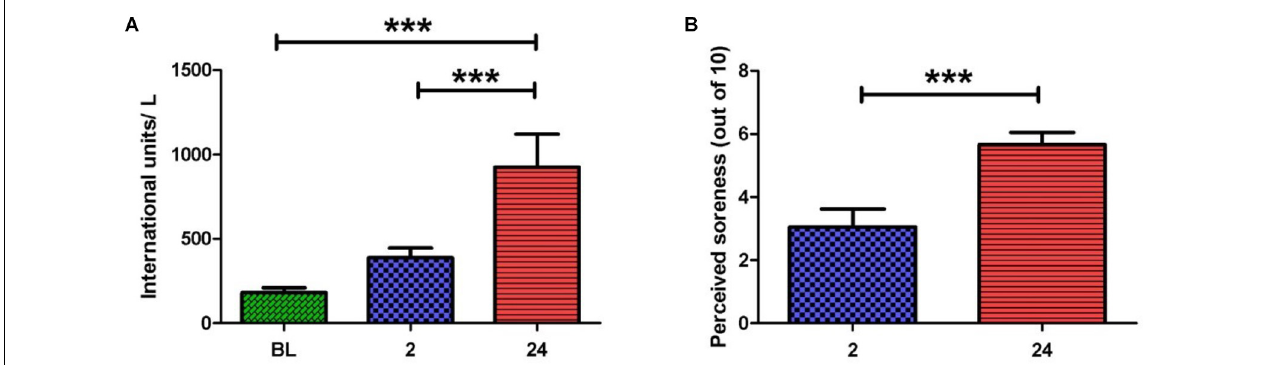
FIGURE 1 | (A) Serum creatine kinase activity before and after the exercise intervention. Values are represented in international units (IU) per liter. A large increase in scores is seen at 2 and 24 h post-exercise. (B) Perceived muscle pain of the anterior quadriceps upon walking. A large increase in pain scores is seen at 24 h when compared to 2 h post-exercise (one-way ANOVA. Mean ± SEM; ∗∗∗ p < 0.001; n = 9).